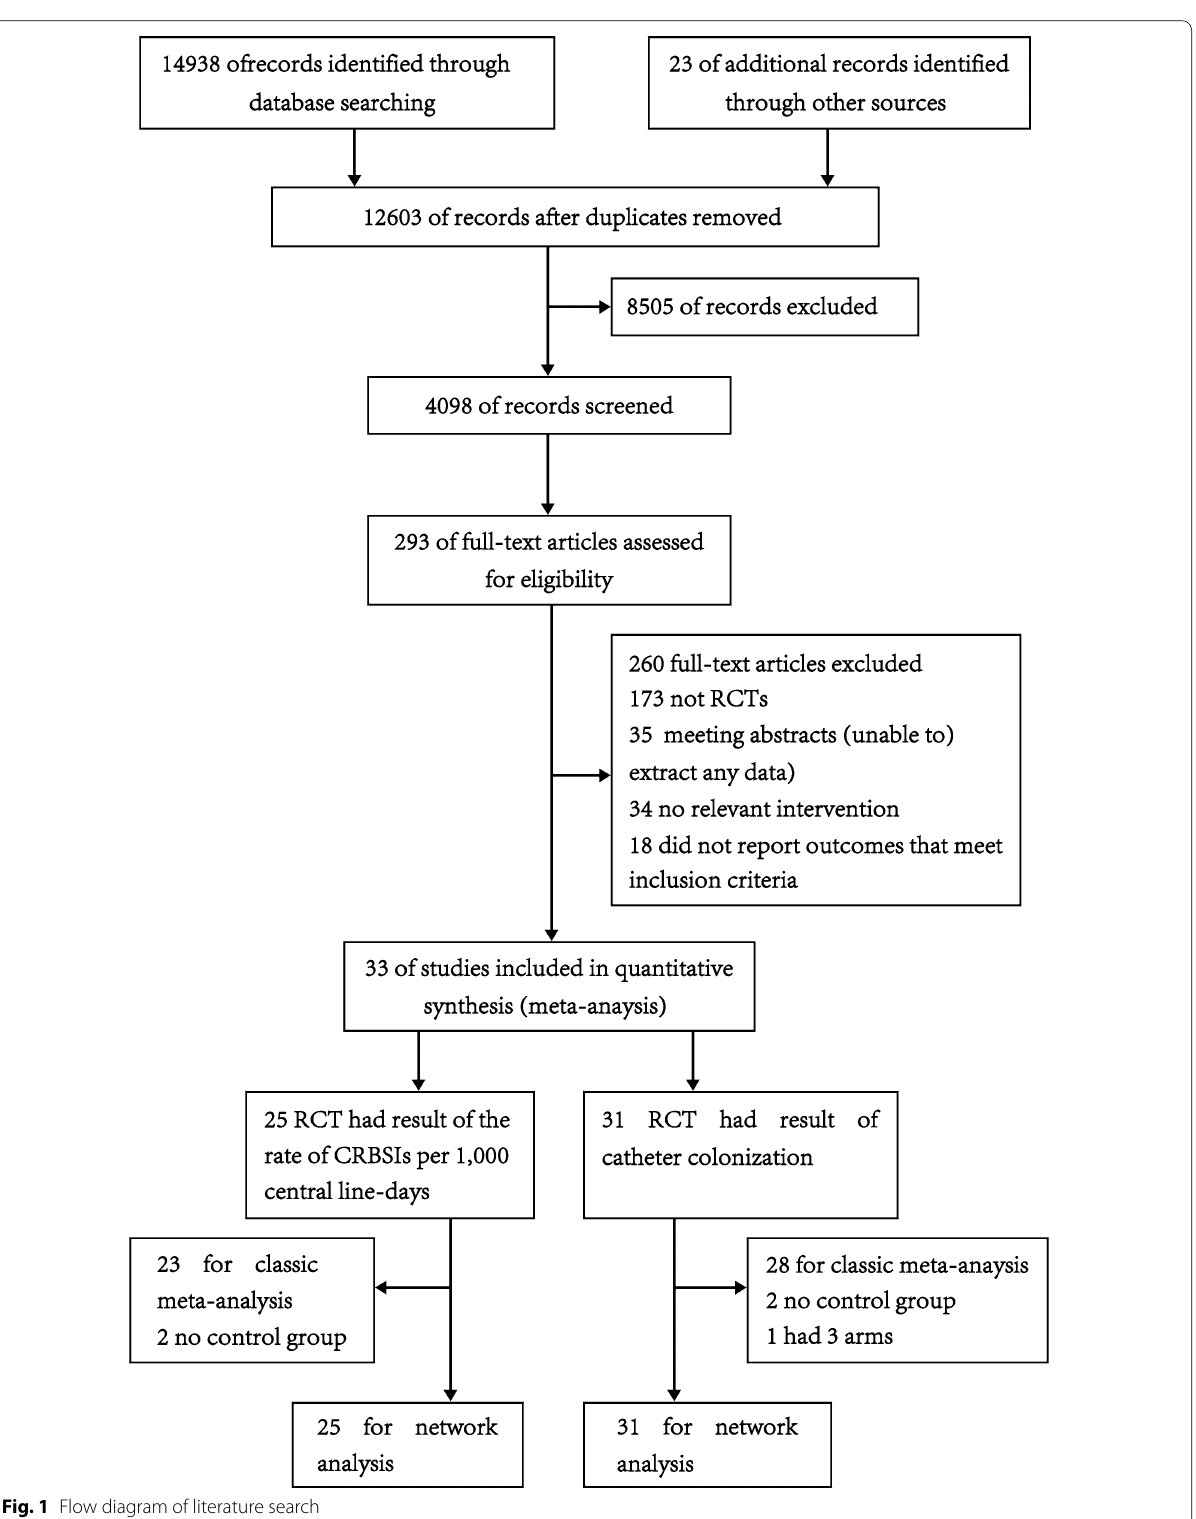
Fig. 1 Flow diagram of literature